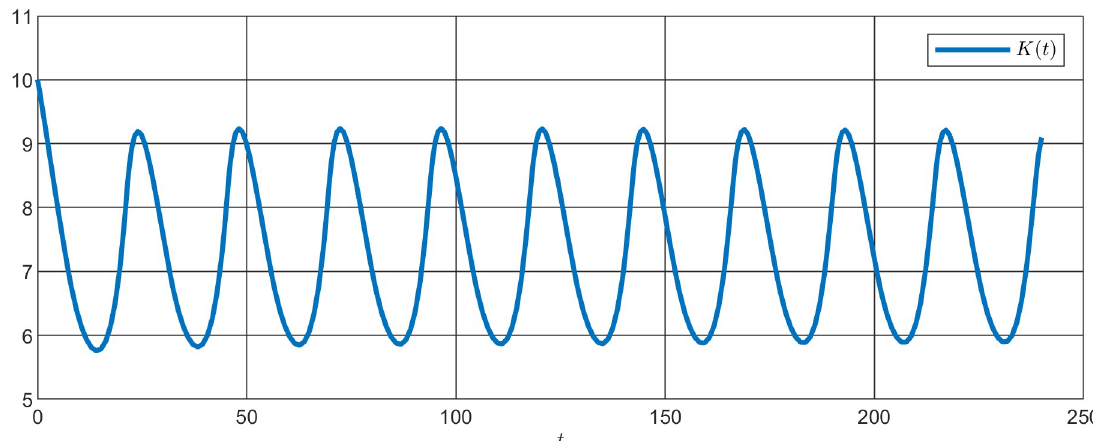
Fig 13. Simulation of the output K(t) of the nominal clockwork with a period of 23.60